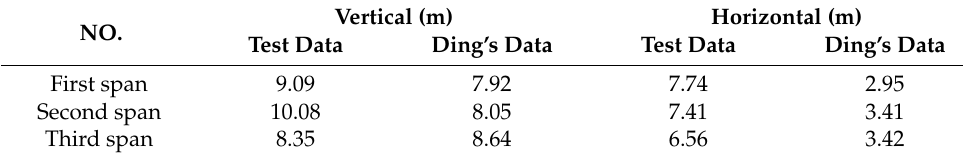
Table 4. Galloping amplitude comparison of each span conductor at wind velocity of 8 m/s. Vertical (m) Horizontal (m) NO. Test